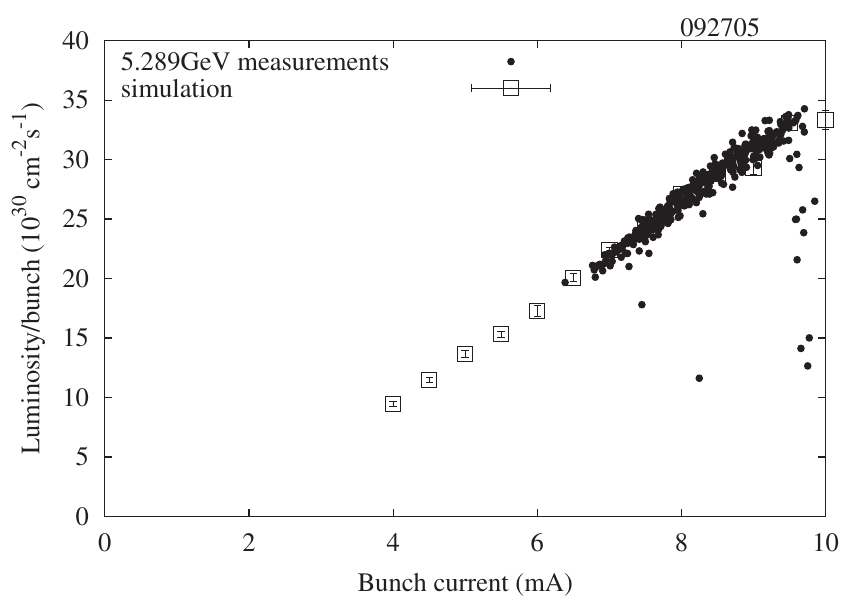
FIG. 7. The measured luminosity points are collected once every 3 min over the 24 h period during which the highest specific luminosity was achieved in the high-energy configuration, March 3, 2001. The simulation is with 500 macroparticles and 100 000 turns.